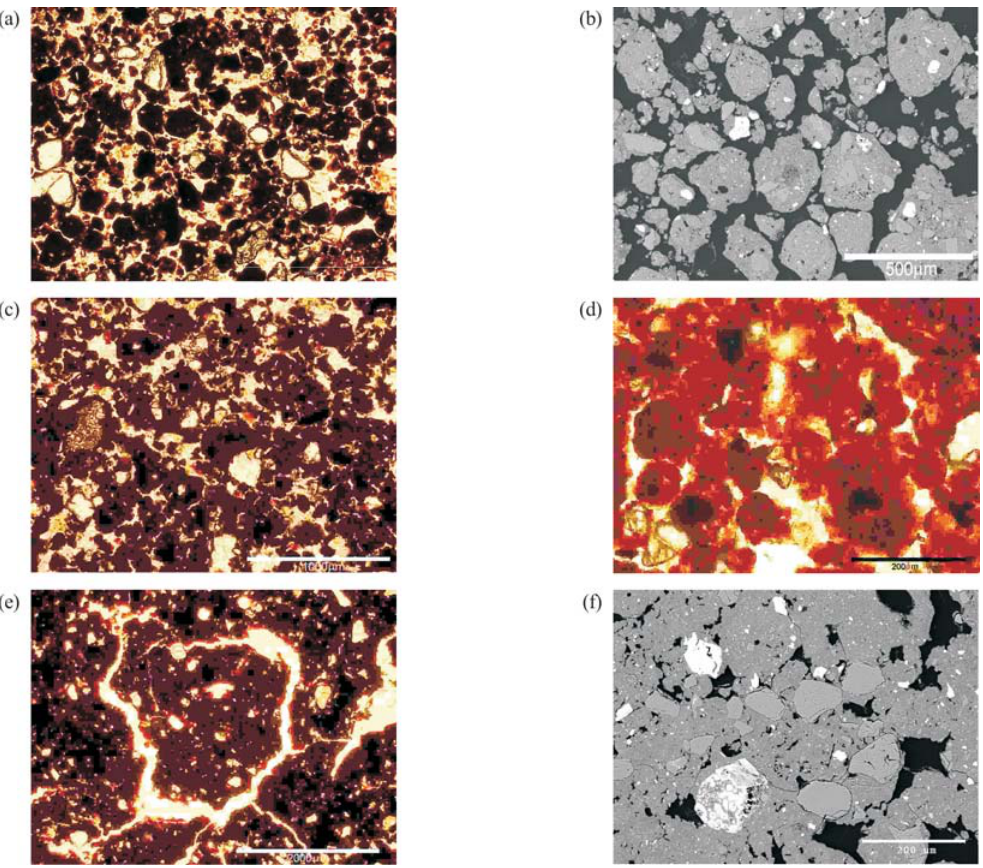
Figure 2. Microphotographs of the transformation process between the Bfl (profile 1) and the Bni (profile 1) horizons. (a) Micro-granular structure with packing voids and an enaulic C/F related distribution, (b) Backscattered electron image detailing the micro-granular structure, (c) Coalesced micro-granular aggregates in the transition horizons (Bni2, profile 1), (d) Detail of the coalesced micro-granular aggregates and the formation of polyconcave vughs (indicated as PV), (e) Porphyric polyhedral aggregates separated by planes and polyconcave vughs in the interior of the aggregates, (f) Detail of the polyconcave vughs (in black) in the interior of the polyhedral aggregates (backscattered electron